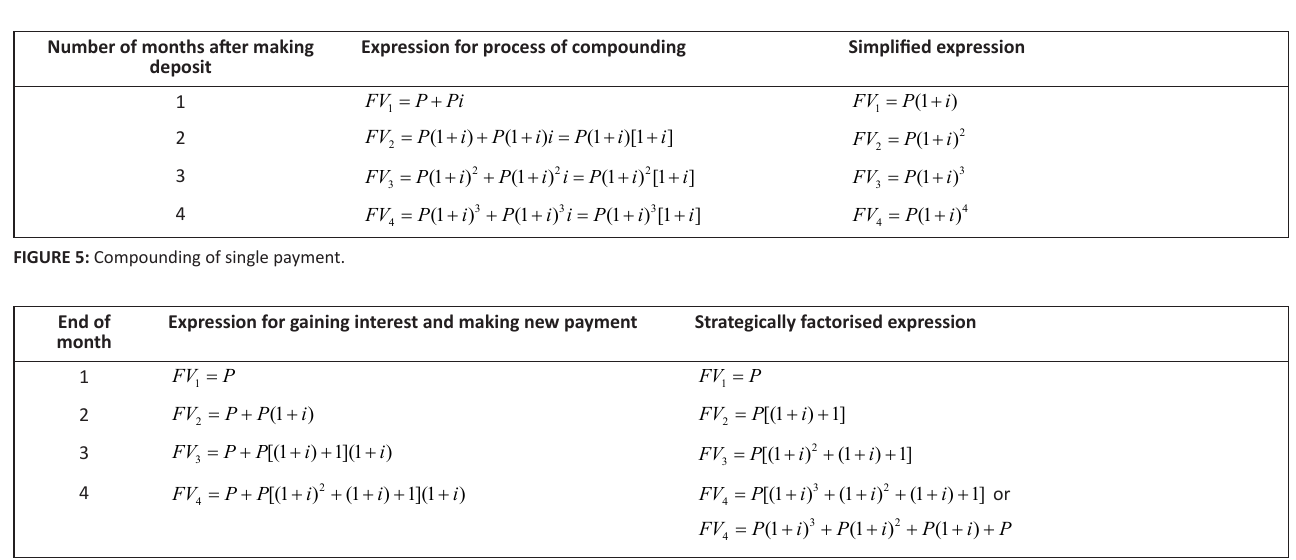
FIGURE 7: Multiple payments using individual payment